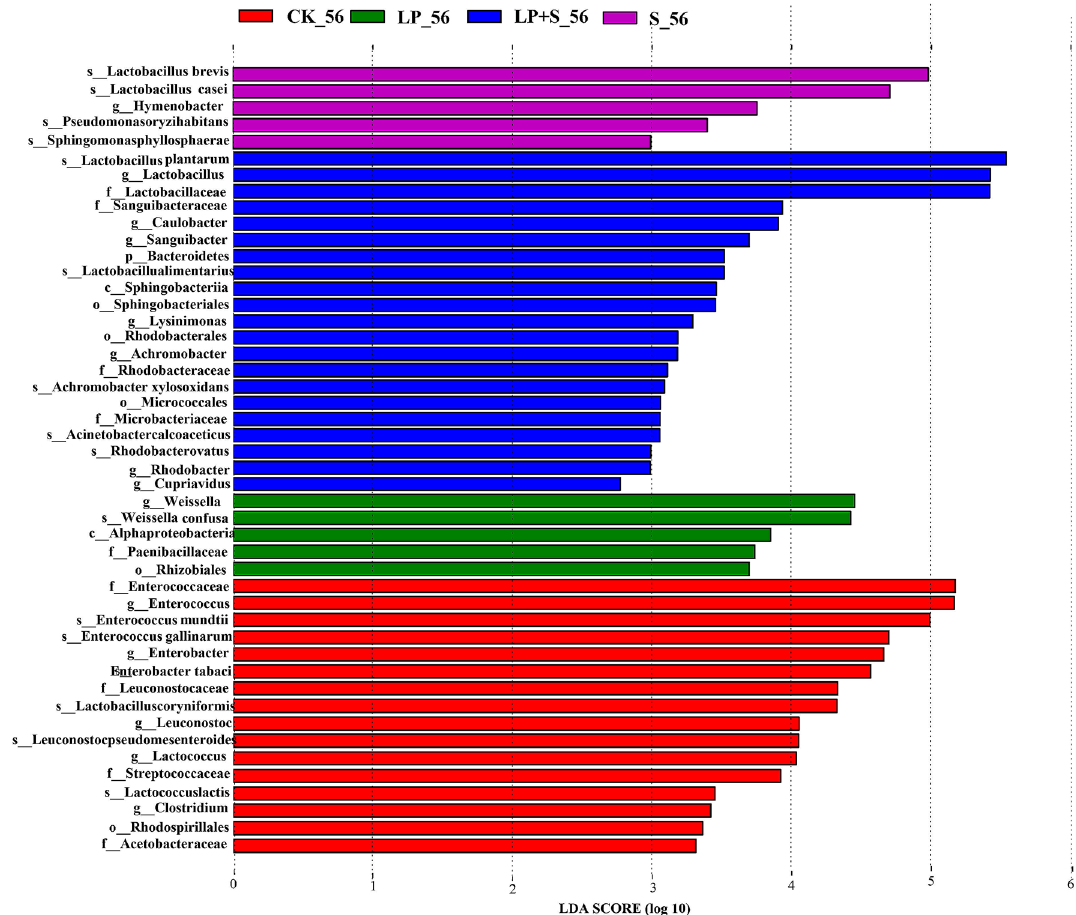
Figure 3. Comparison of bacterial variations using the LEfSe online tool for alfalfa silage at 56 days (CK, control; LP, Lactobacillus plantarum ; S, sucrose; LP + S, the addition of both sucrose and Lactobacillus plantarum